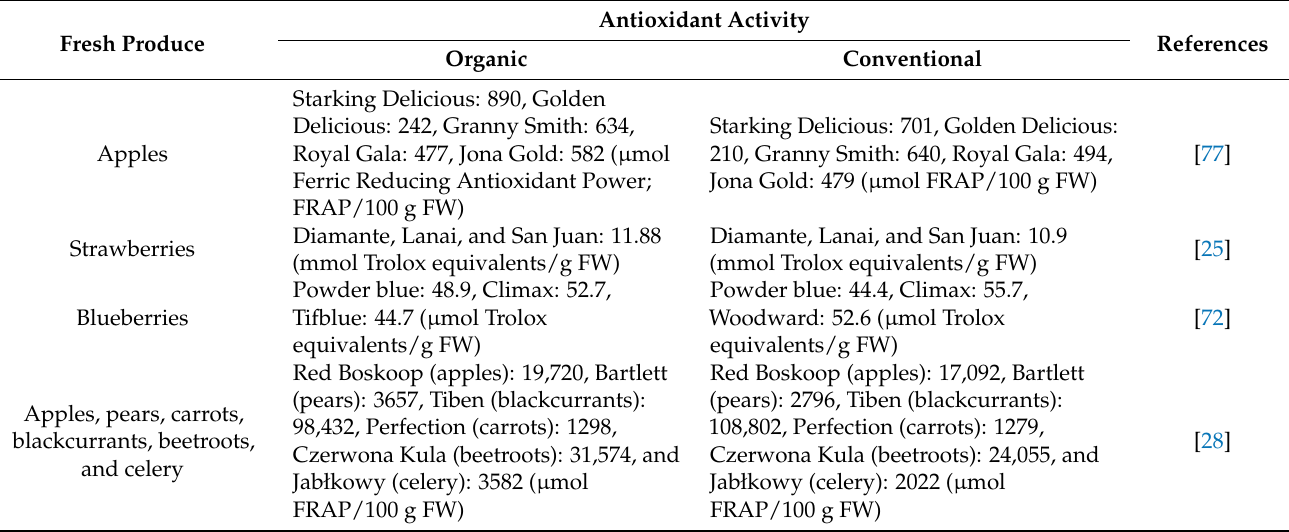
Table 11. Antioxidant activity of organic and conventional fresh